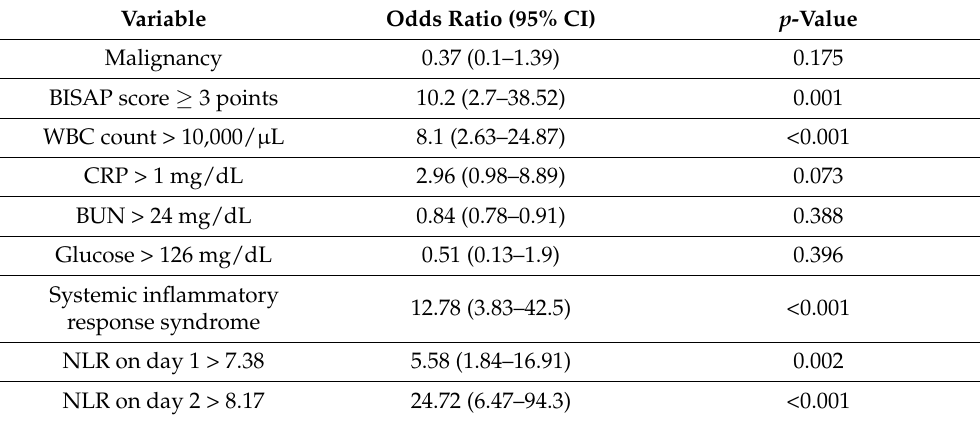
Table 3. Simple logistic regression of factors predicting severe post-ERCP pancreatitis.